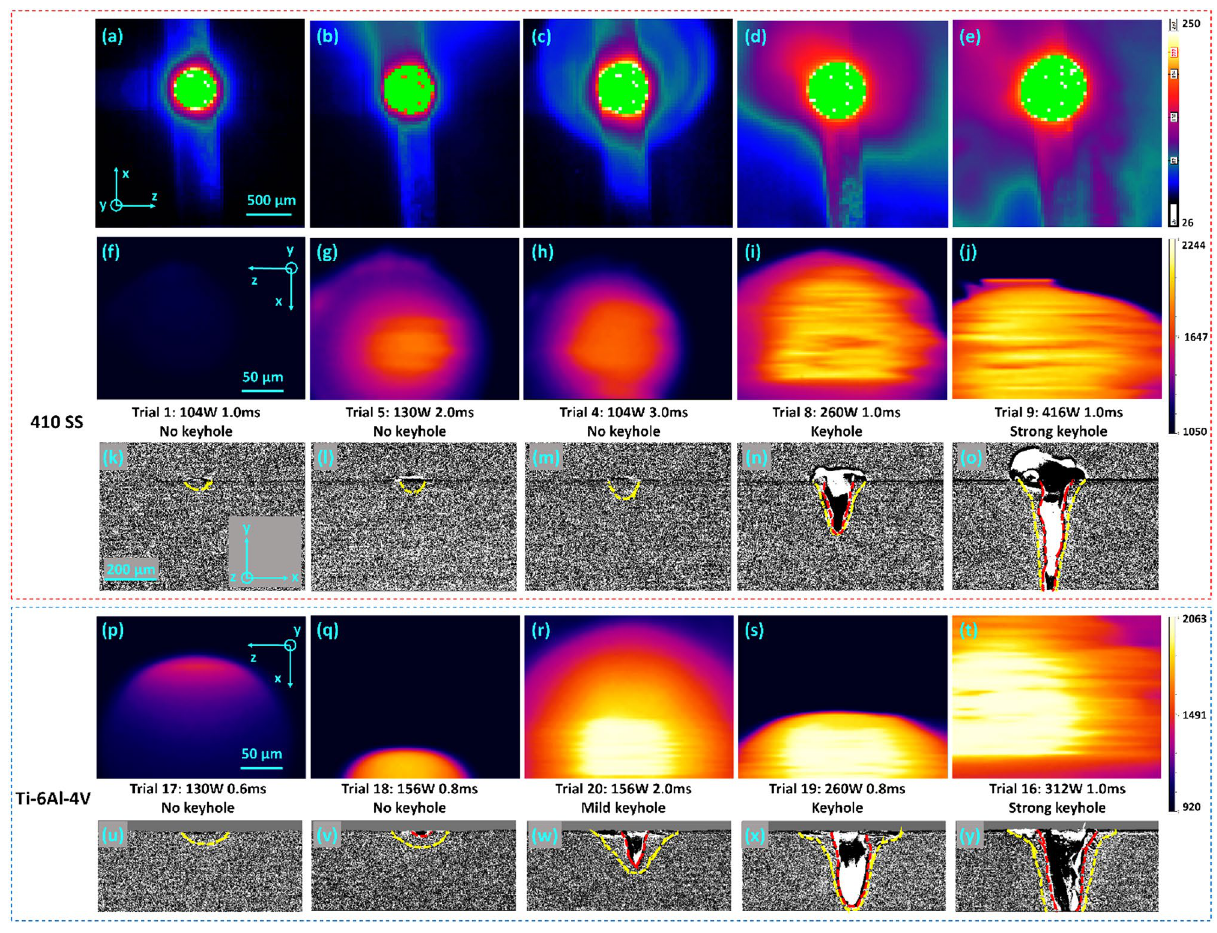
Figure 5. ( a – e ) The high-speed IR observations of different processing conditions at the frame right before the laser shuts off. The last two ( d and e ) have strong vapor plumes indicating a keyhole. ( f – j and p – t ) The high- spatial IR observations of different processing conditions at the frame right before the laser shuts off where i, j, r, s, t have fringe patterns, which indicate a keyhole. ( k – o and u – y ) The corresponding x-ray images right before the laser shuts off, where yellow dashes indicate the solid–liquid boundary and red dashes indicate the liquid– gas boundary. (Temperatures all in